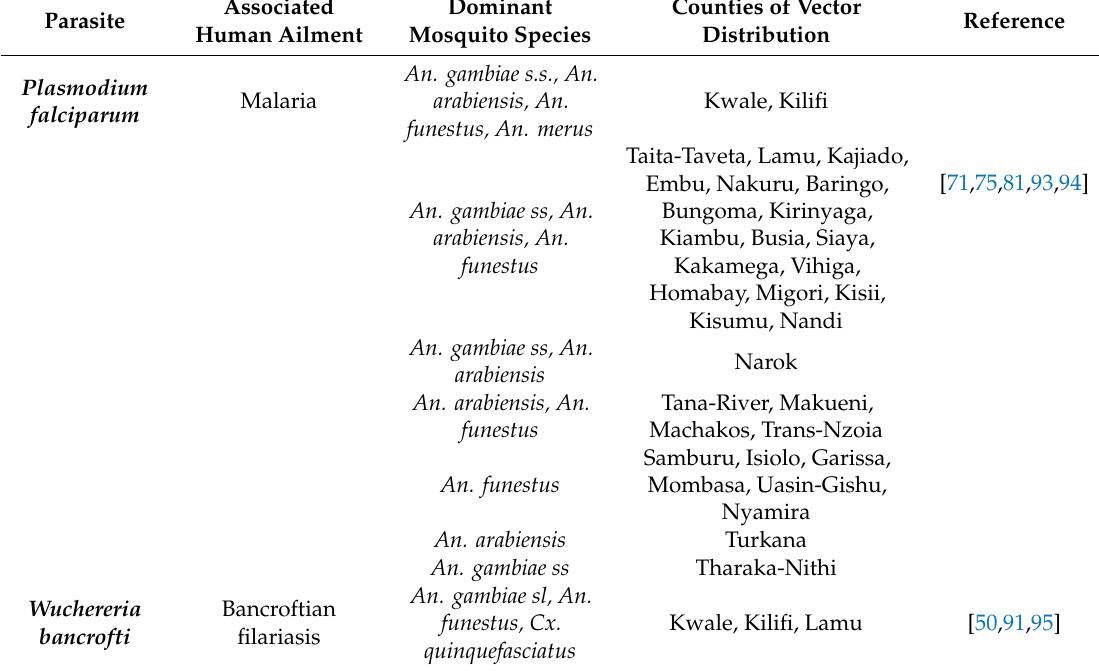
Table 2. Summary of the dominant malaria and Bancroftian filariasis mosquito vectors distributed in